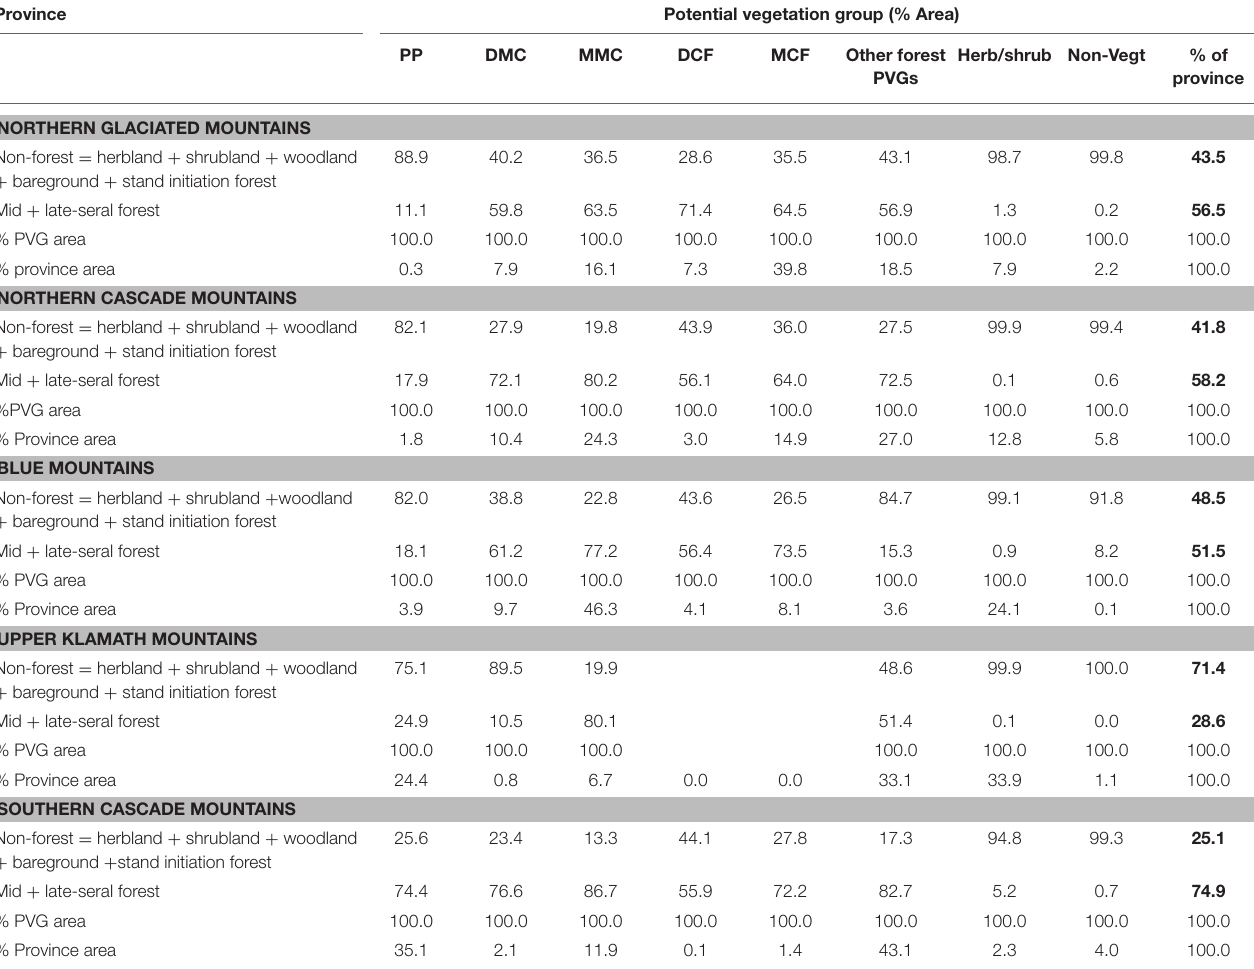
TABLE 1 | Area of nonforest, pre-forest ( = early seral), and mid- to late-seral conditions in 5 Inland Northwest provinces ( Figure 7 ) shown by potential vegetation group. Province Potential vegetation group (% Area)